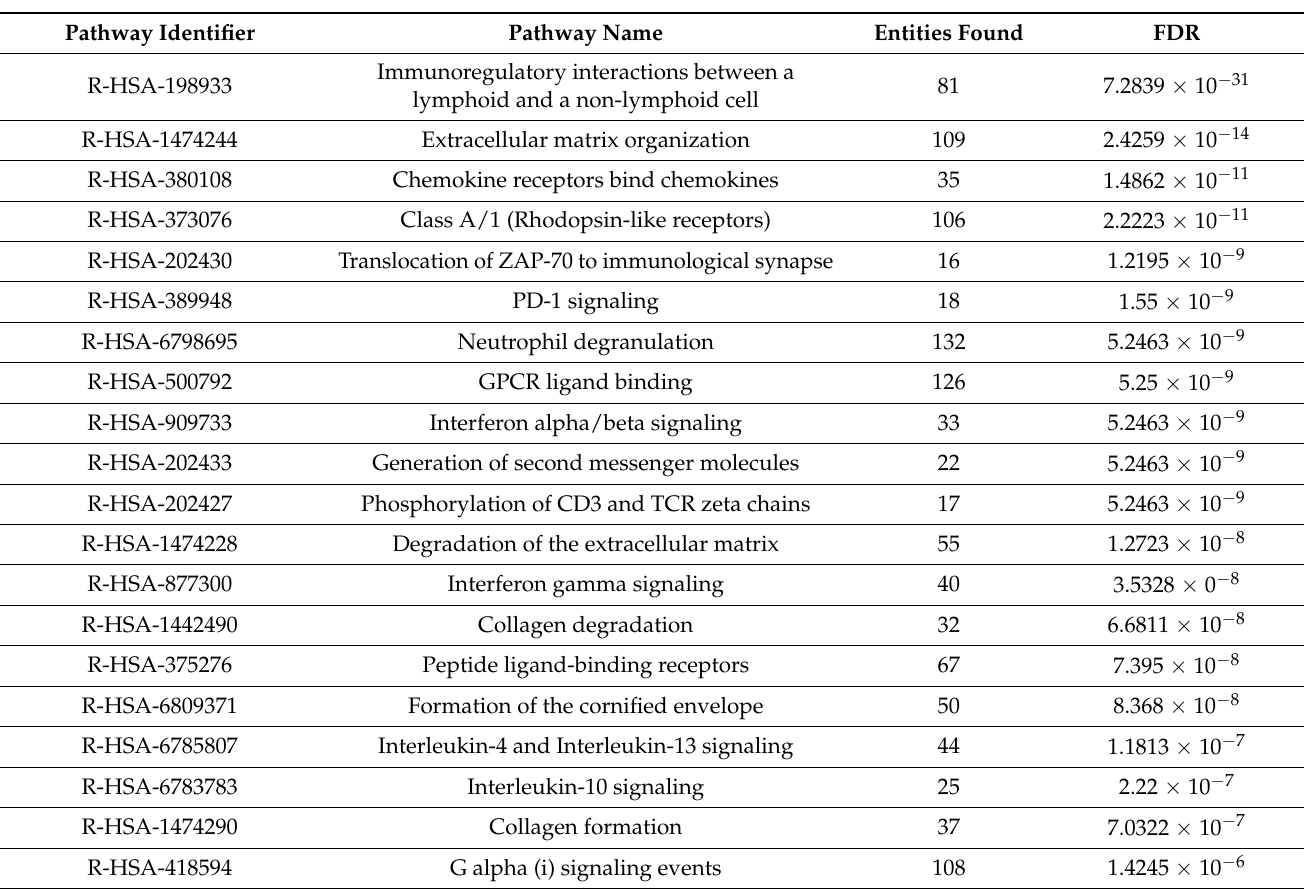
Table 2. Reactome analysis highlighting the 20 pathways with the lowest FDR, which are associated with upregulated